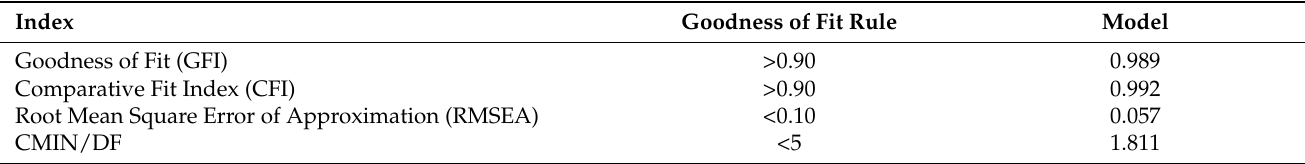
Table 7. Fitting Index of SEM Model.